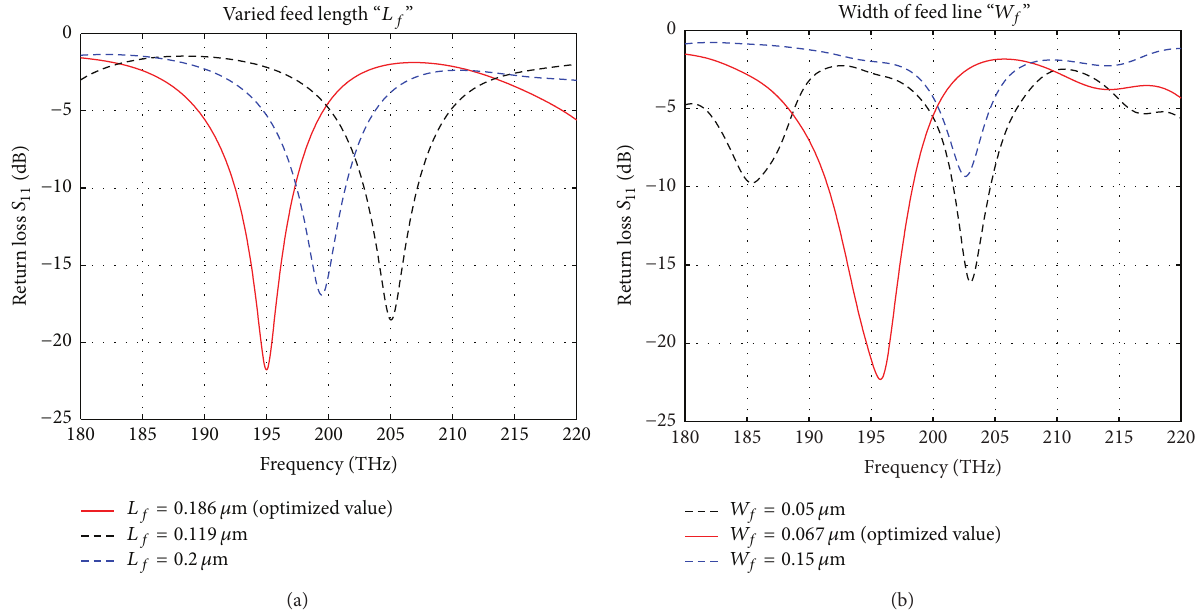
Figure 3: Optimized parameters. (a) Length of nanostrip. (b) Width of nanostrip.